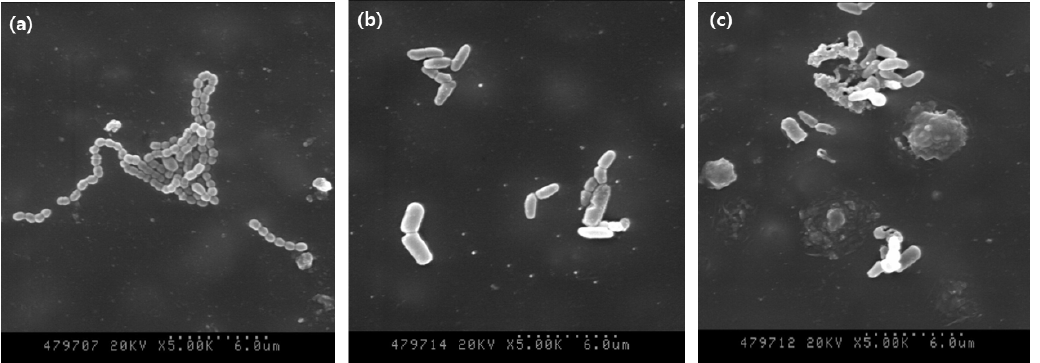
Figure 3. Field-emission scanning electron microscope images of S. mutans : ( a ) control group, ( b ) nitrogen-plasma-treated group, and ( c ) air-plasma-treated group.